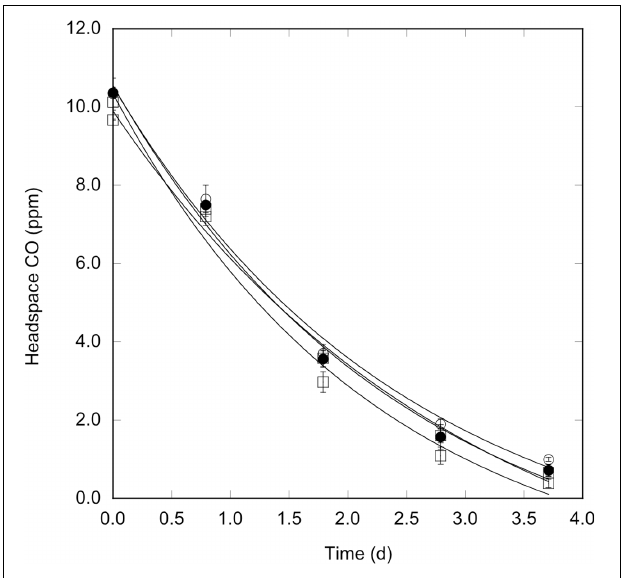
FIGURE 2 | Perchlorate tolerance by Haloarcula sp. PCN7 under oxic conditions. CO uptake by Haloarcula sp. PCN7 during aerobic incubations with no perchlorate (